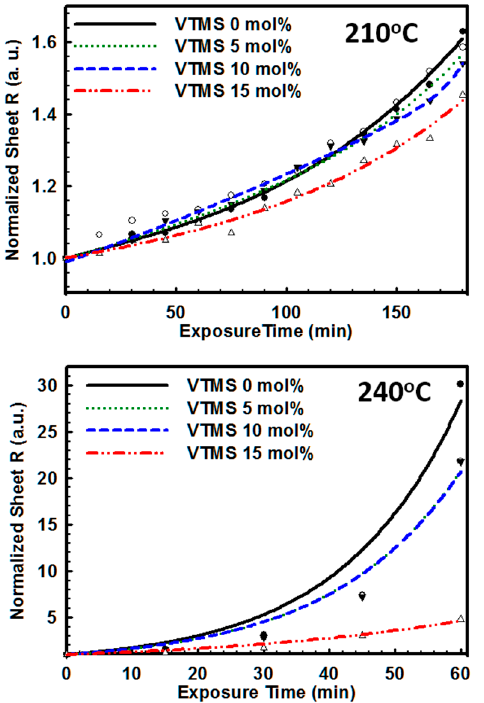
Figure 7. Thermal stability spectra of PEDOT:PSS and PEDOT:P(SS- co -VTMS) with the thermal exposure test.